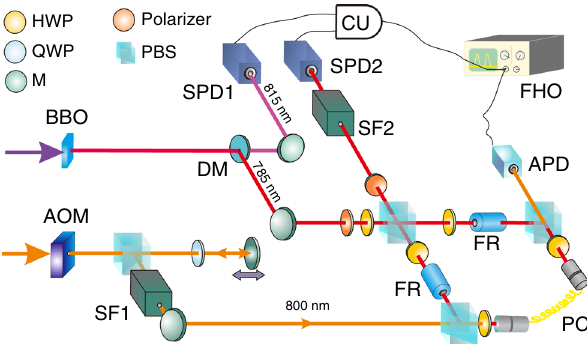
Fig. 2 Experimental setup for measuring the Kerr non-linearity of a